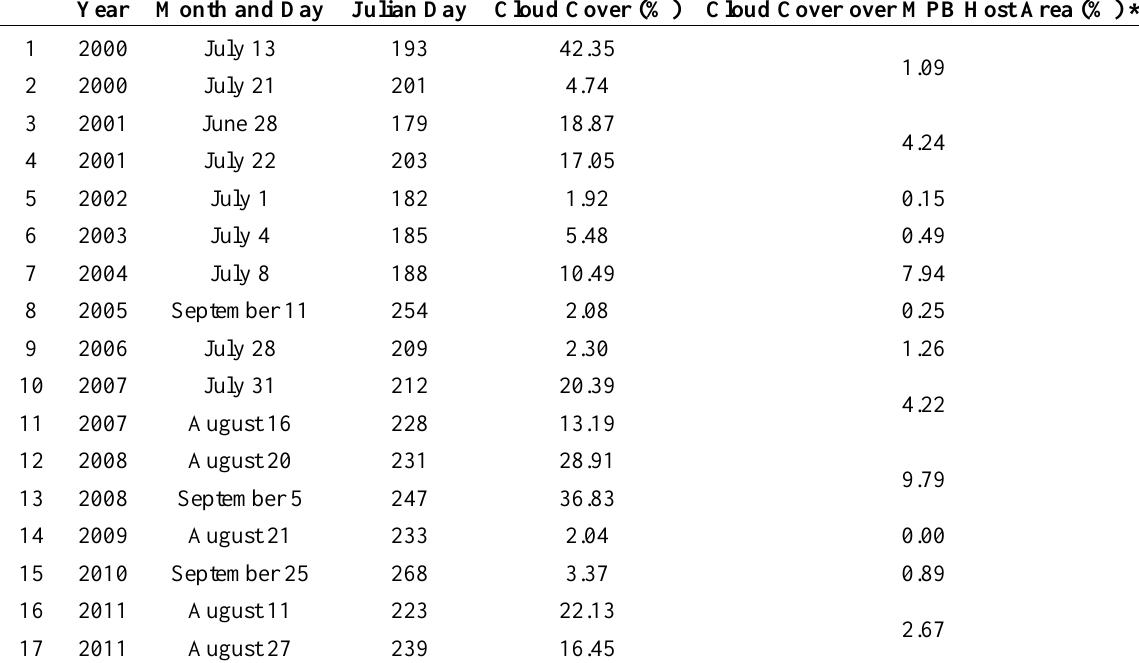
Table 1. Characteristics of the Landsat images used in this